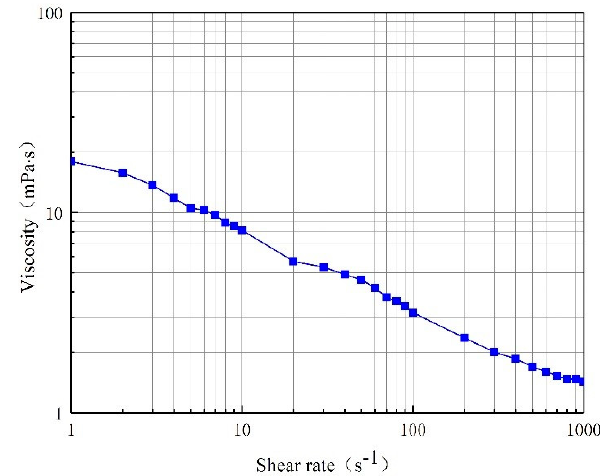
Figure 3. Rheological curve of the polymer solution with a polymer concentration of 1000 mg/L.